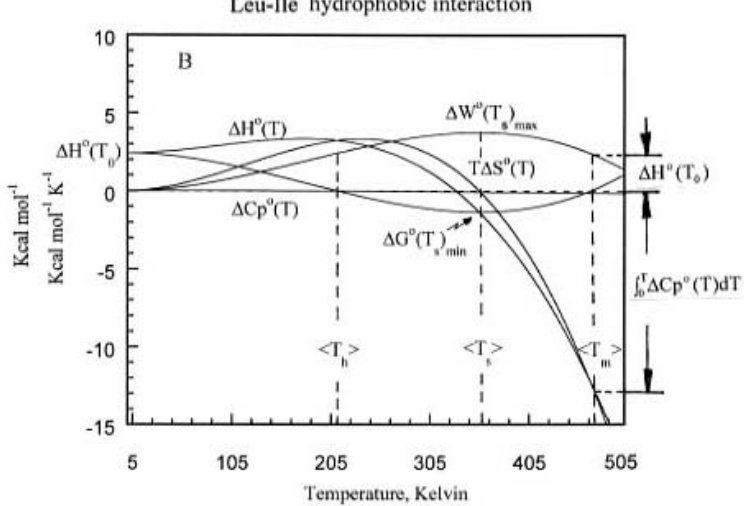
FIGURE 2B. Thermodynamic plot of the Planck-Benzinger thermal work function for Leu-Ile hydrophobic interaction. Each data point between 0 and 500 K was evaluated with extrapolation of F-statistics. The solid line represents fitted data, F = 0.0001, thus the goodness of fit of the experimental data was 99.9% or better in each